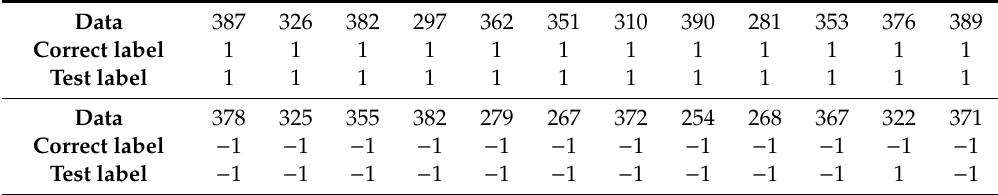
Table 1. Classification test data and labels.